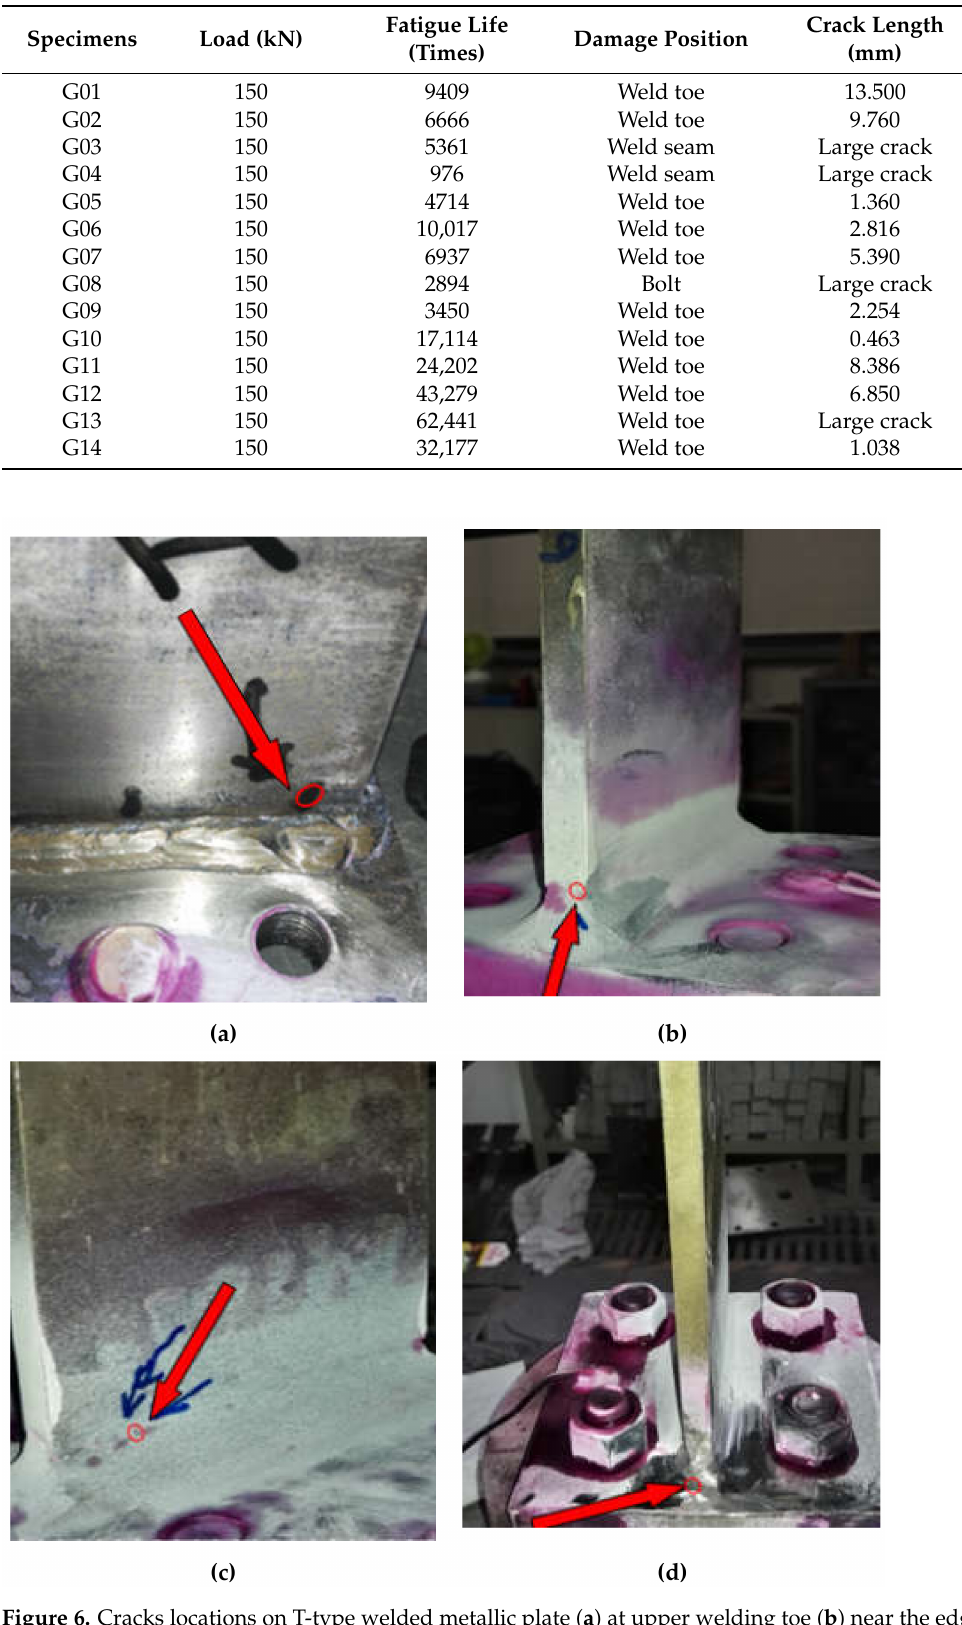
Table 4. Test results of T-type plate joint.